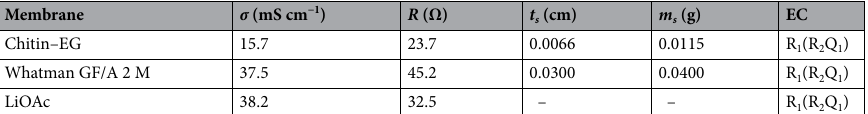
Table 1. Ionic conductivity ( σ ), bulk resistance of electrolyte ( R ), thickness in swollen state ( t s ), and mass ( m s ) for examined membranes in 2 M LiOAc aqueous solution (24 h) and equivalent circuit (EC) used in the EIS fitting